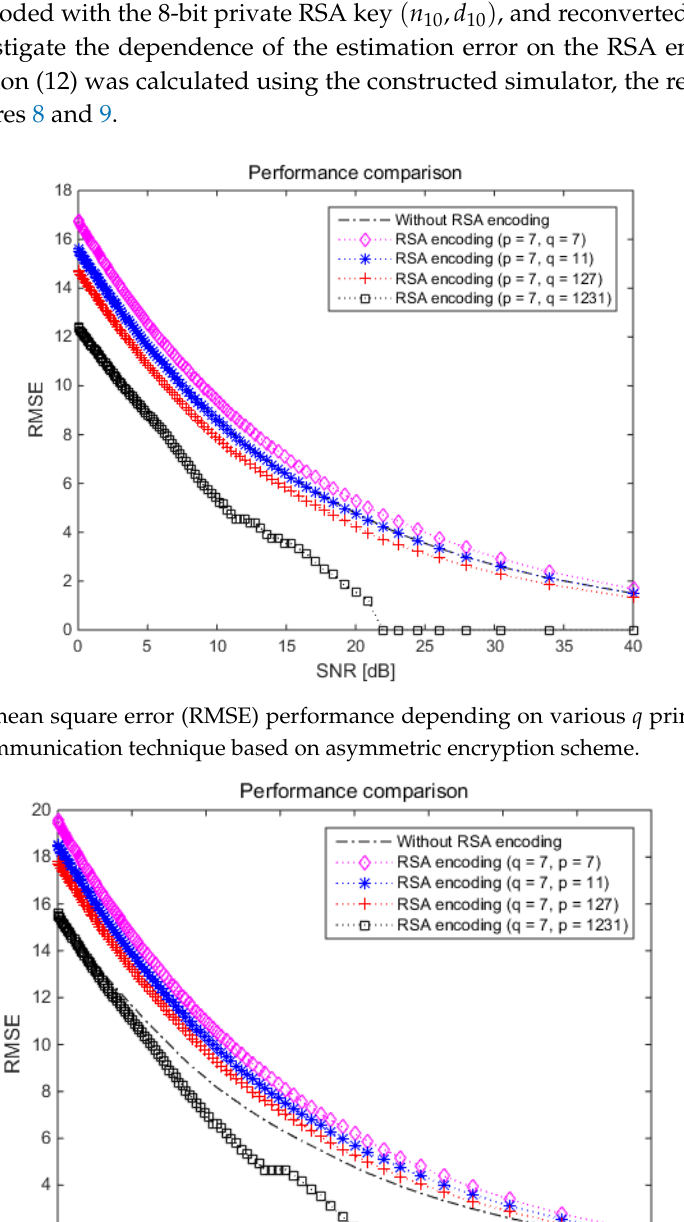
Figure 9. RMSE performance depending on various p prime numbers in proposed VL communication technique based on asymmetric data encryption scheme.